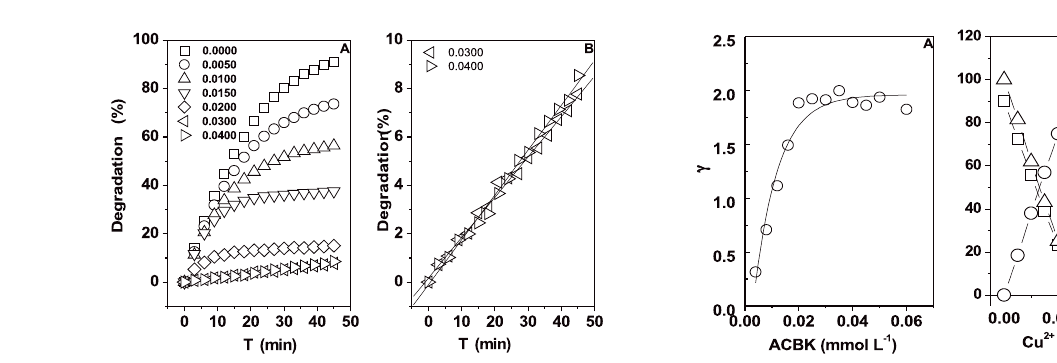
Figure 8. The degradation of 0.050 mmol L -1 ACBK with controlled Cu 2+ concentrations (0.000, 0.0050, 0.0100, 0.0150, 0.0200, 0.0300 and 0.0400 mmol L -1 ) at pH 5.0 buffer solutions with H O at different times (A). Plots of δ 2 2 vs. time with the addition of 0.0300 and 0.0400 mmol L -1 Cu 2+ (B).